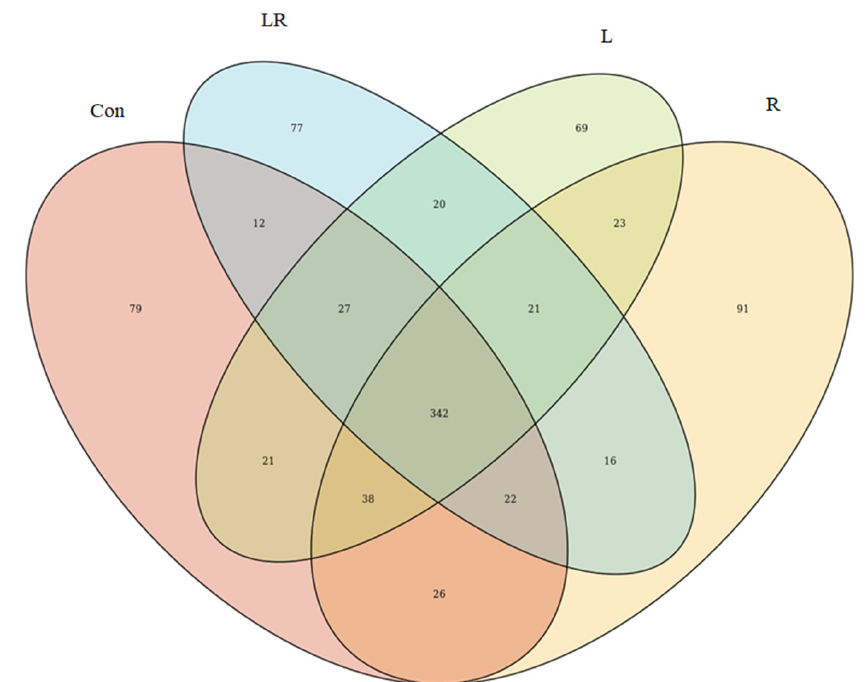
Figure 2. Venn diagram of the operational taxonomic unit distribution of the cecum microbial community. Each ellipse represents one group. The value of each region represents the number of OTUs corresponding to the region. Con, basal diet; R, control plus 0.6% Hydrastis canadensis root; L, control plus 0.6% Hydrastis canadensis leaf; LR, control plus 0.6% Hydrastis canadensis root and leaf.